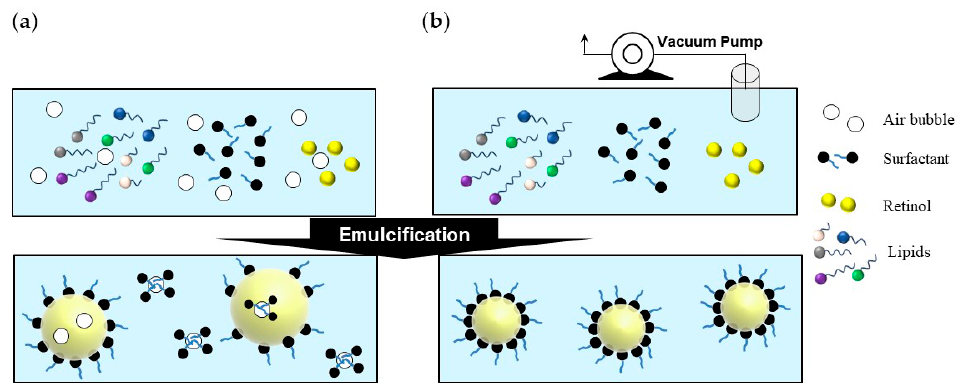
Figure 1. Schematic showing the stepwise differences of the ( a ) normal and ( b ) vacuum emulsification processes. In the case of the high-pressure homogenization technique, which is a two-step process executed after the pre-emulsion process, the composition conditions for NLC synthesis in the pre-emulsion step, such as the ratio of solid/liquid lipid and lipid/surfactant, have limitations caused by the instability of the lipid–water phase. The constraints of the components associated with the formation of the capsule owing to the instability of the lipid–water phase in the pre-emulsion process constitute one of the disadvantages of the high-pressure homogenization technique. For example, if the amount of surfactant is less than 10% subject to the conditions of formula #1 in Table 1, a phase separation occurred